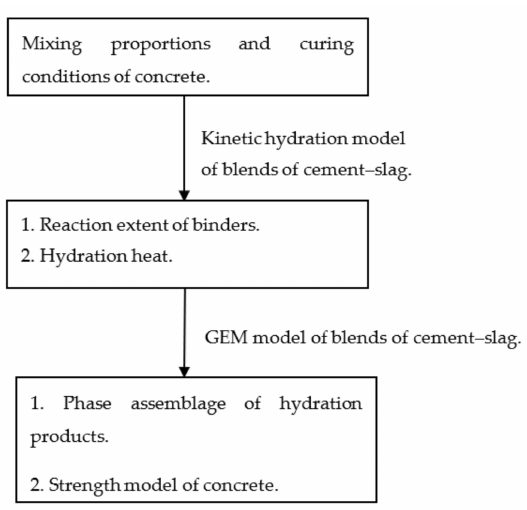
Figure 1. The simulation framework of cement–slag concrete.